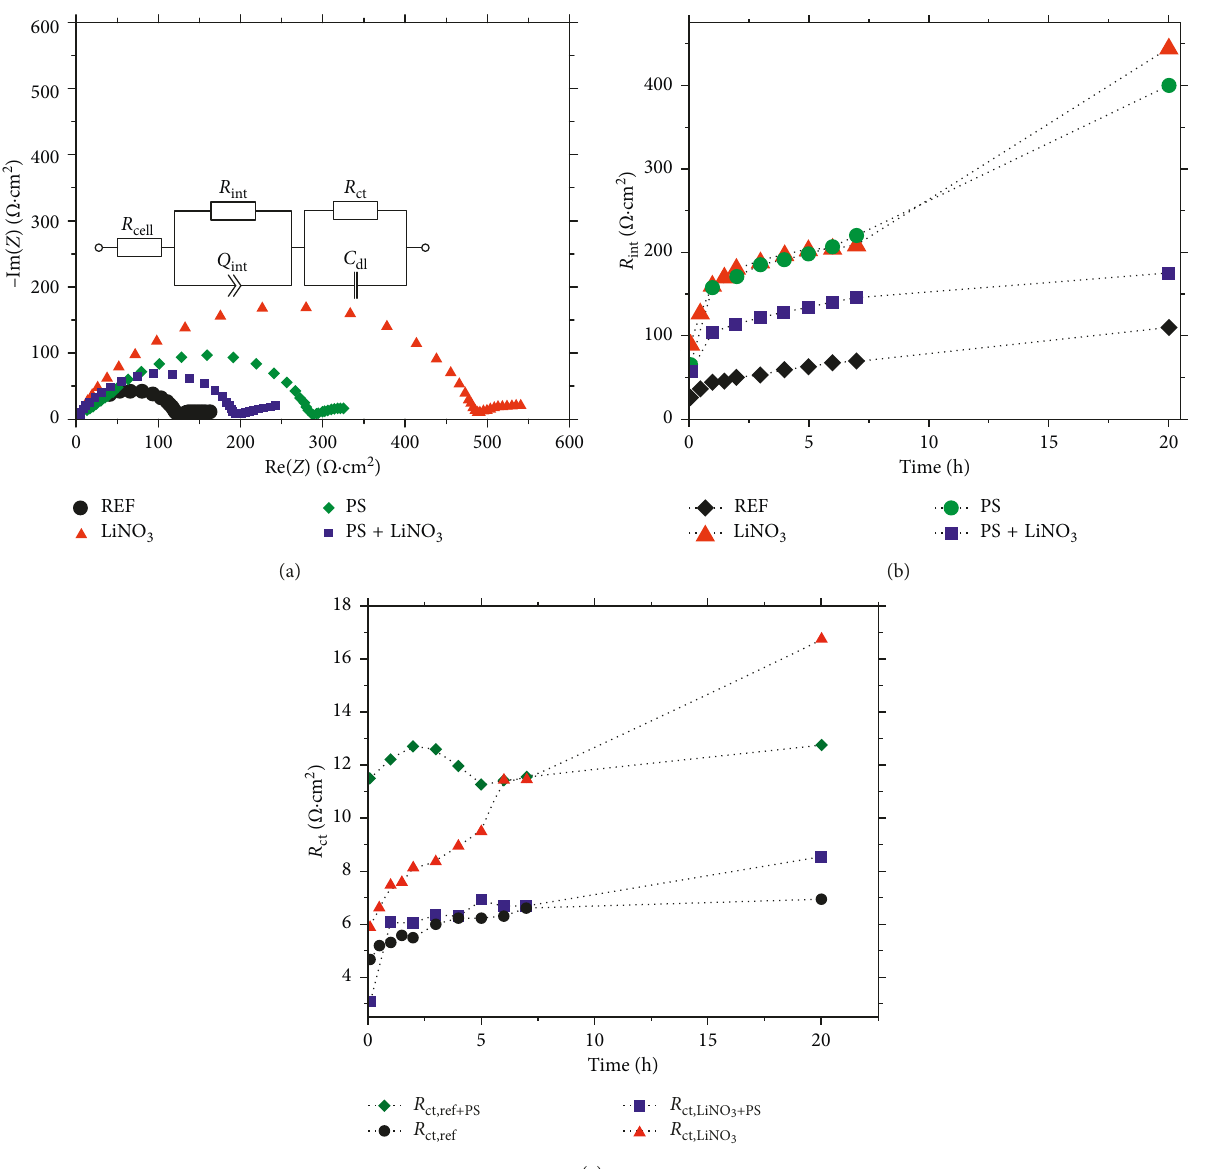
Figure 1: Nyquist impedance diagrams for anodes tested in symmetric cells, after 20h contact time with electrolyte 1M LiTFSI DOL/ TEGDME (7:3) (black); 1 M LiTFSI, 0.2M LiNO 3 , DOL/TEGDME (7: 3) (red); 1M LiTFSI, PS DOL/TEGDME (7: 3) (green); and 1 M LiTFSI, 0.2M LiNO 3 , PS DOL/TEGDME (7: 3) (blue) (a), interface resistance ( R int ) (b), and charge transfer resistance ( R ct ) (c) evaluated for different